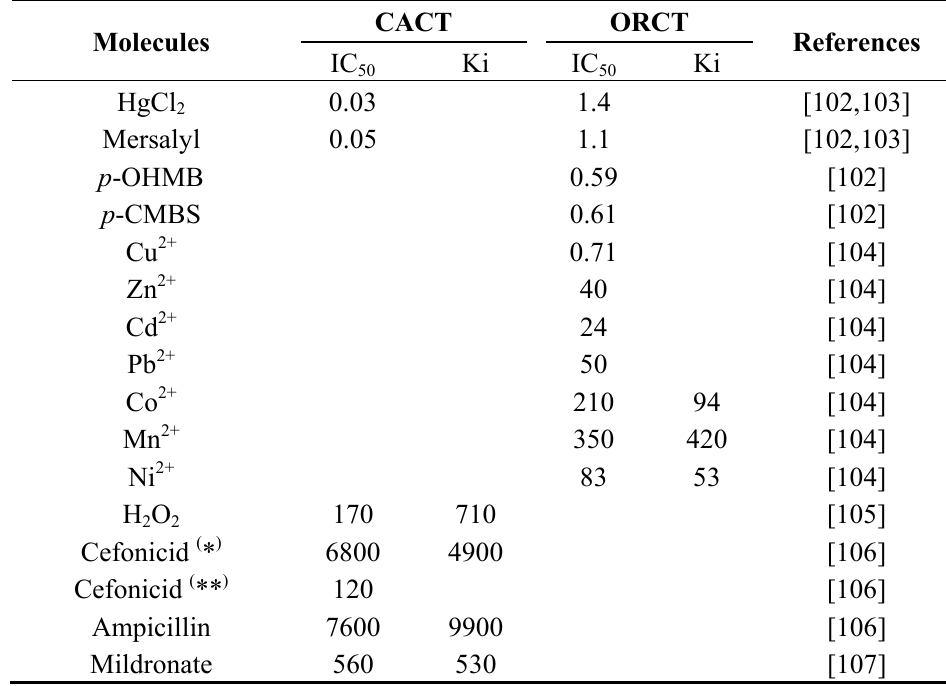
Table 1. IC values and half saturation constants of the reconstituted mitochondrial 50 transporters Transporter (CACT) and Ornithine/Citrulline Transporter (ORCT).